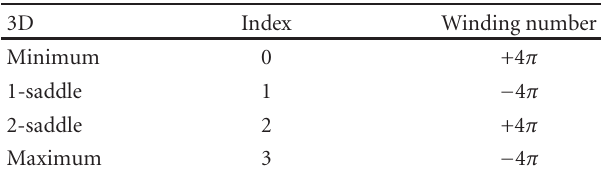
Table 2: Index and winding number of critical points in 3D. Table 3: Correspondence between the sign of the Hessian determi- nant and winding number for critical points in 3D.